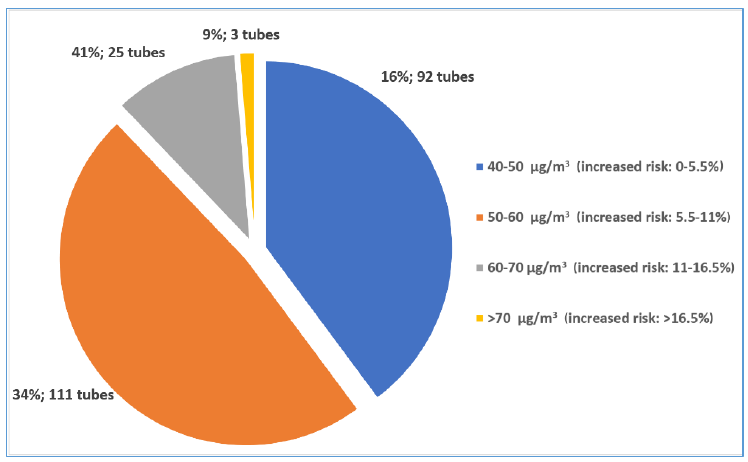
Figure 12. Pie chart of increased risk of premature death corresponding to sampled values.